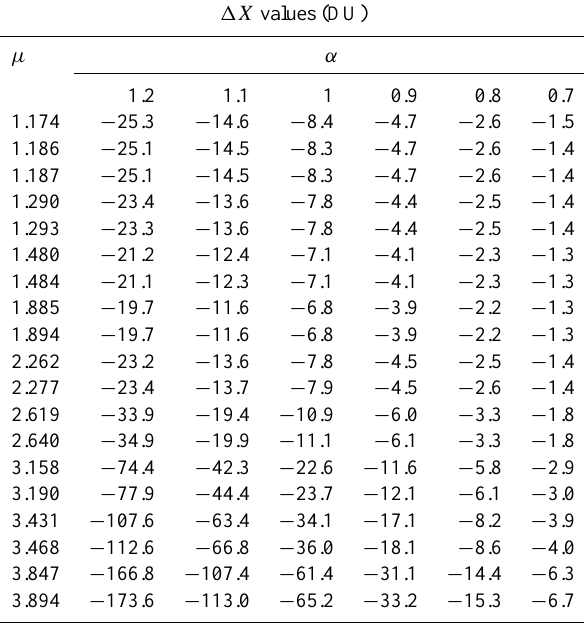
Table 4. X trend and X theor values for the case of 5 September 2012 for R 0 = 10 − 3 . 8 and all α values ( µ 1 = 1 . 0 and µ 2 = 2 . 5 )